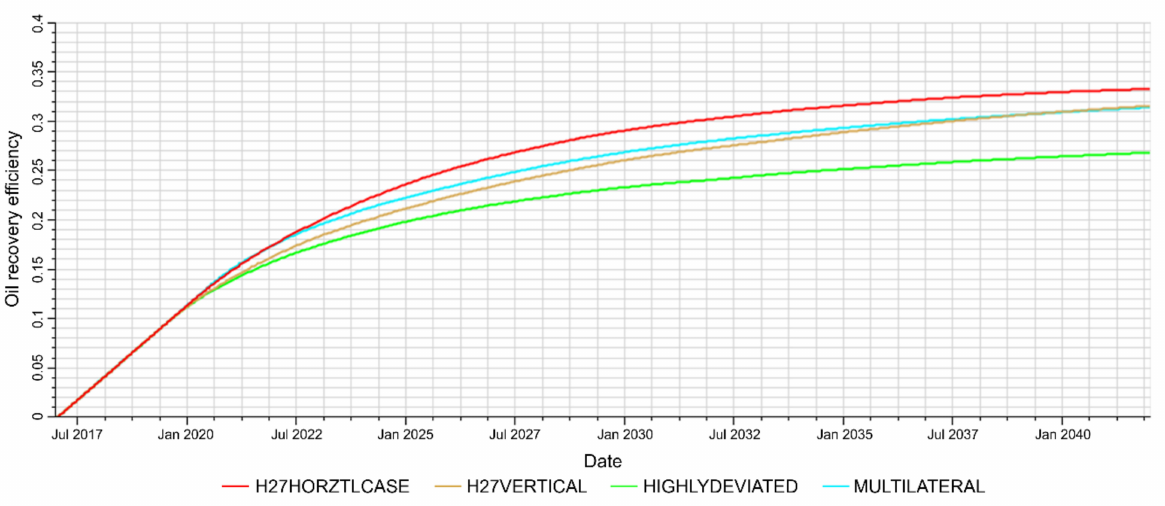
Figure 15. Oil recovery efficiency for each well